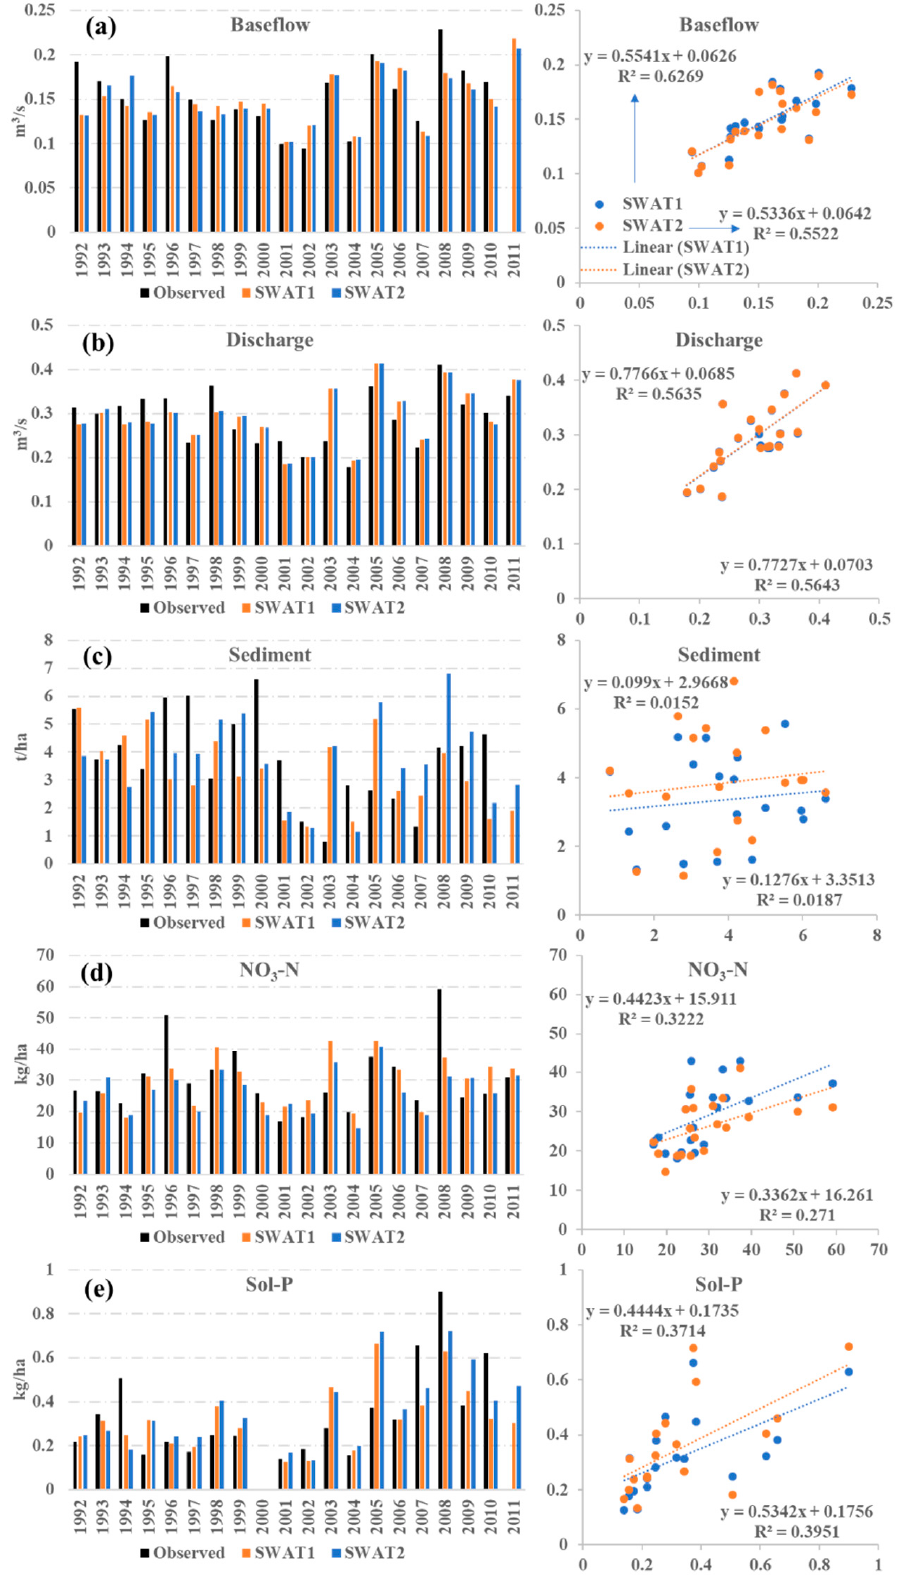
Figure 12. Observed vs. simulated annual ( a ) baseflow and ( b ) flowrate and ( c ) sediment, ( d ) NO 3 -N and ( e ) Sol-P loadings by SWAT1 and SWAT2 from 1992 to 2011.